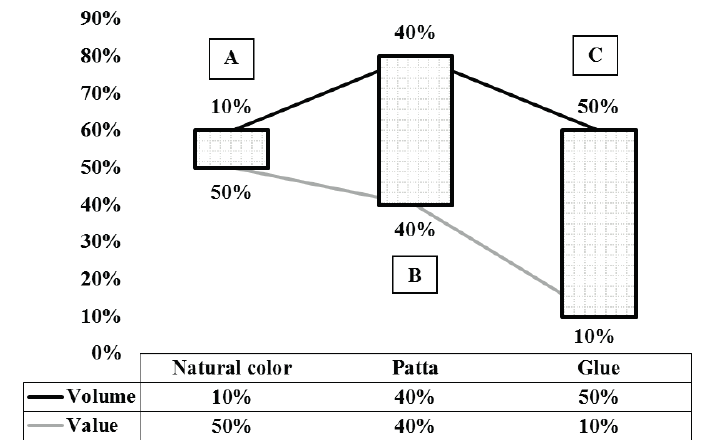
Figure 1. ABC Analysis (source: created by authors)